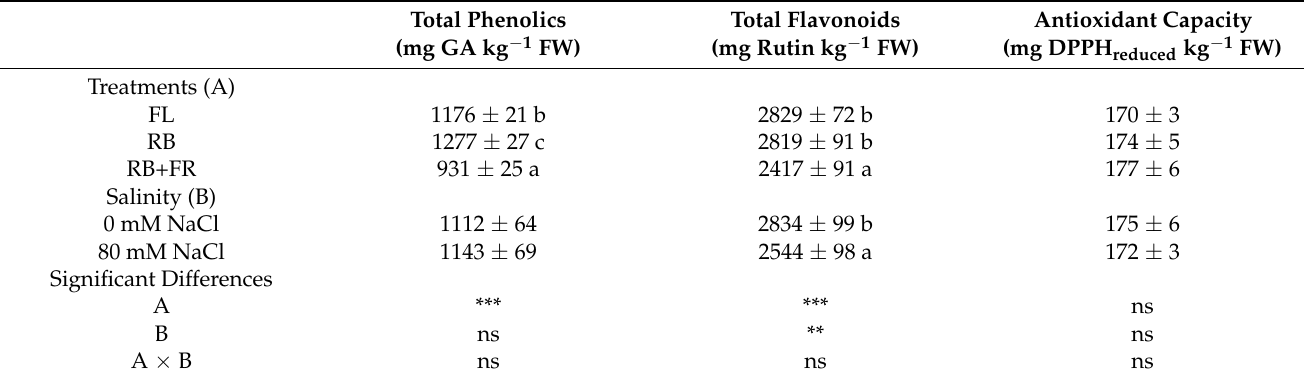
Table 2. Influence of light and salinity (80 mM NaCl) on the total phenolics, total flavonoids and antioxidant capacity of purslane microgreens.